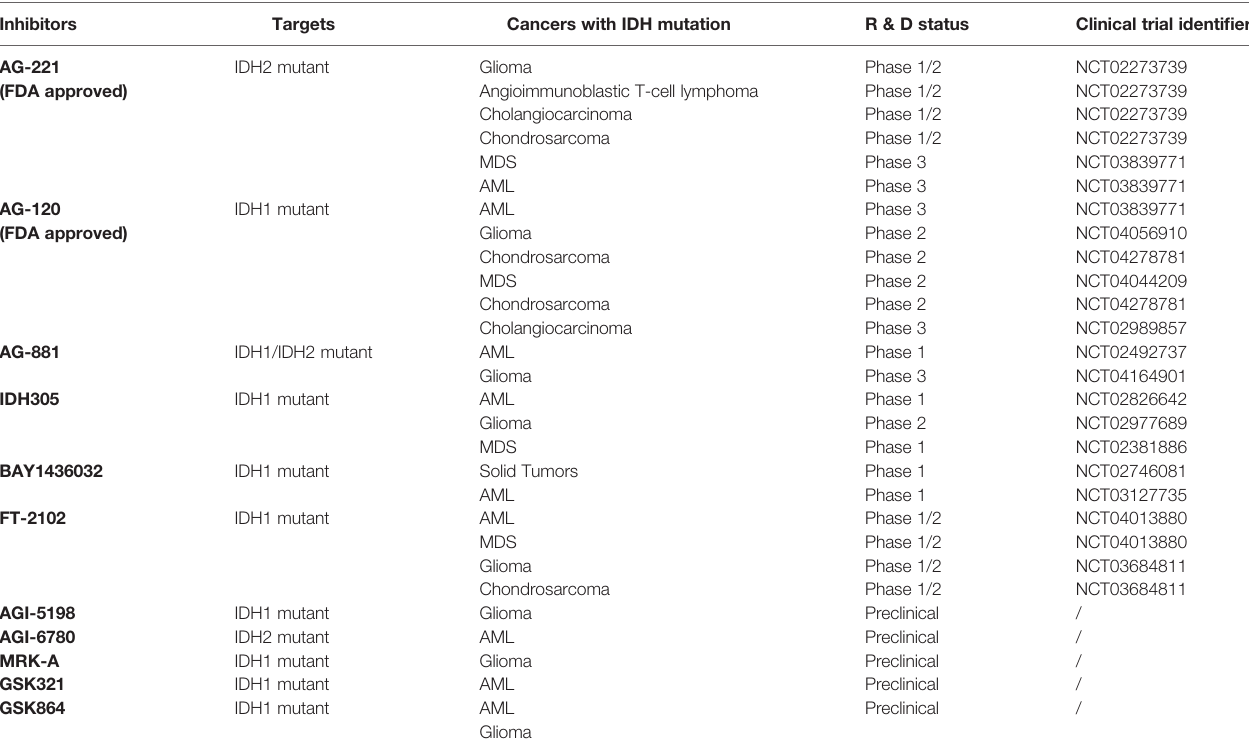
TABLE 3 | Development of IDH Mutant Inhibitors for Cancer Treatment.